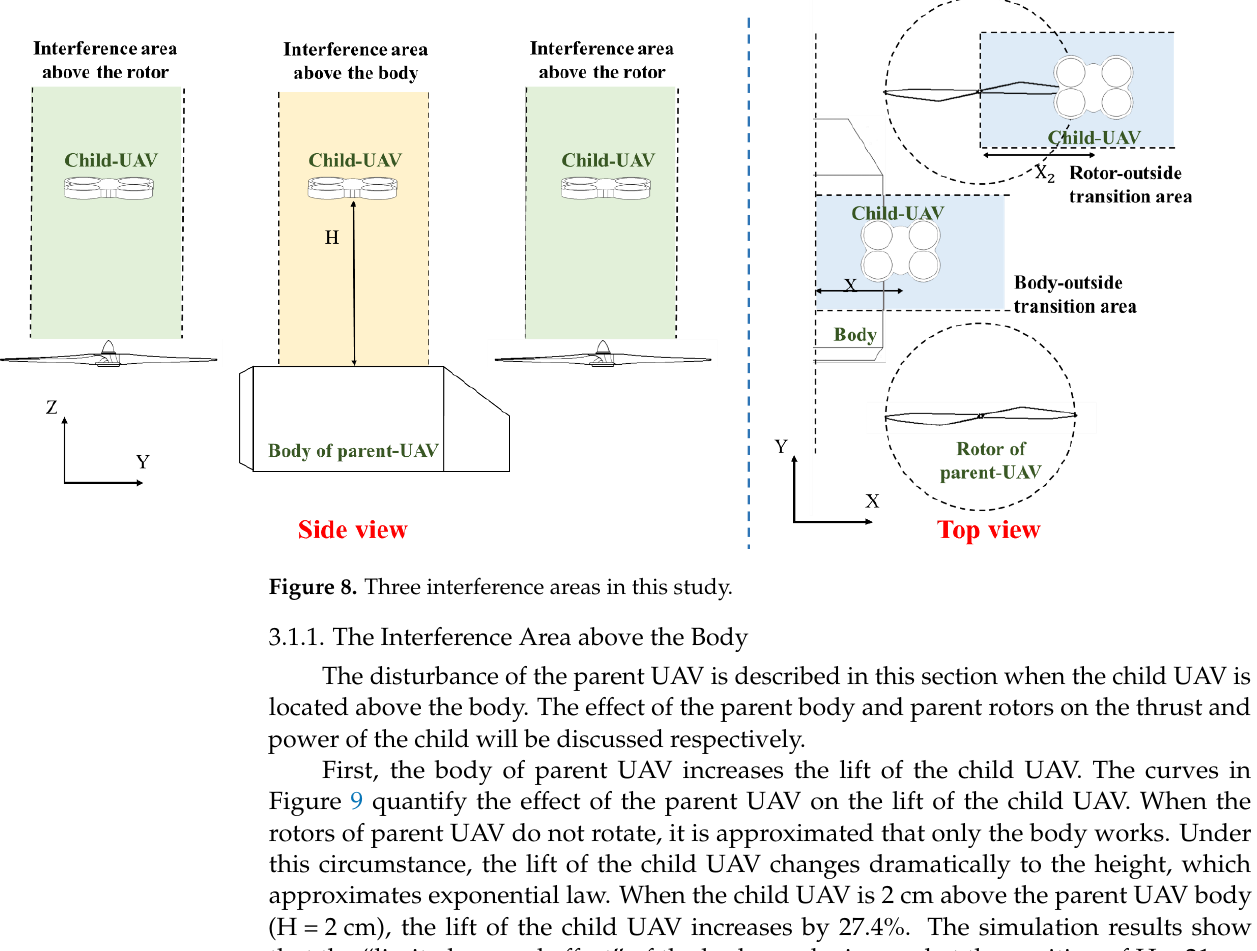
Figure 9. The lift curve of the child UAV in the body interference area.